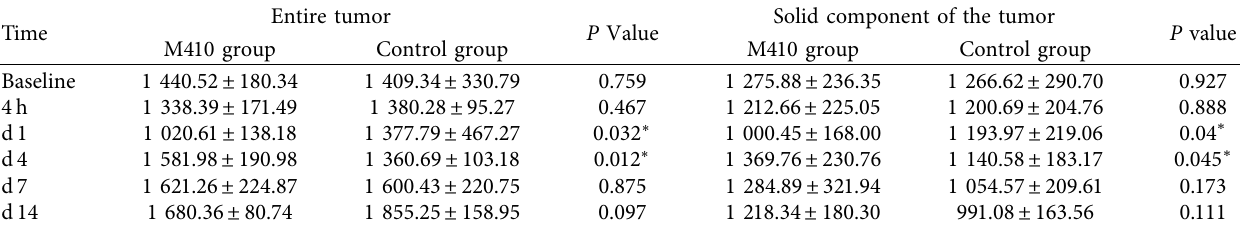
Table 2: The average ADC values of the entire tumor and the solid component of the tumor in two groups (mean ± SD) mm 2 /s.